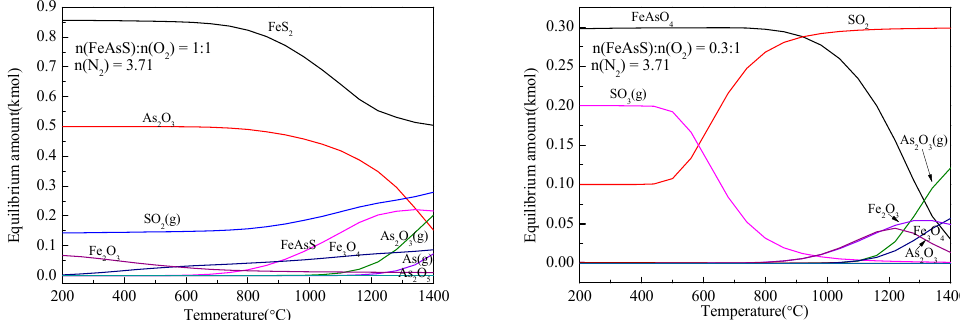
Figure 3. Equilibrium amounts of species as a function of temperature for reaction of FeAsS and O 2 .